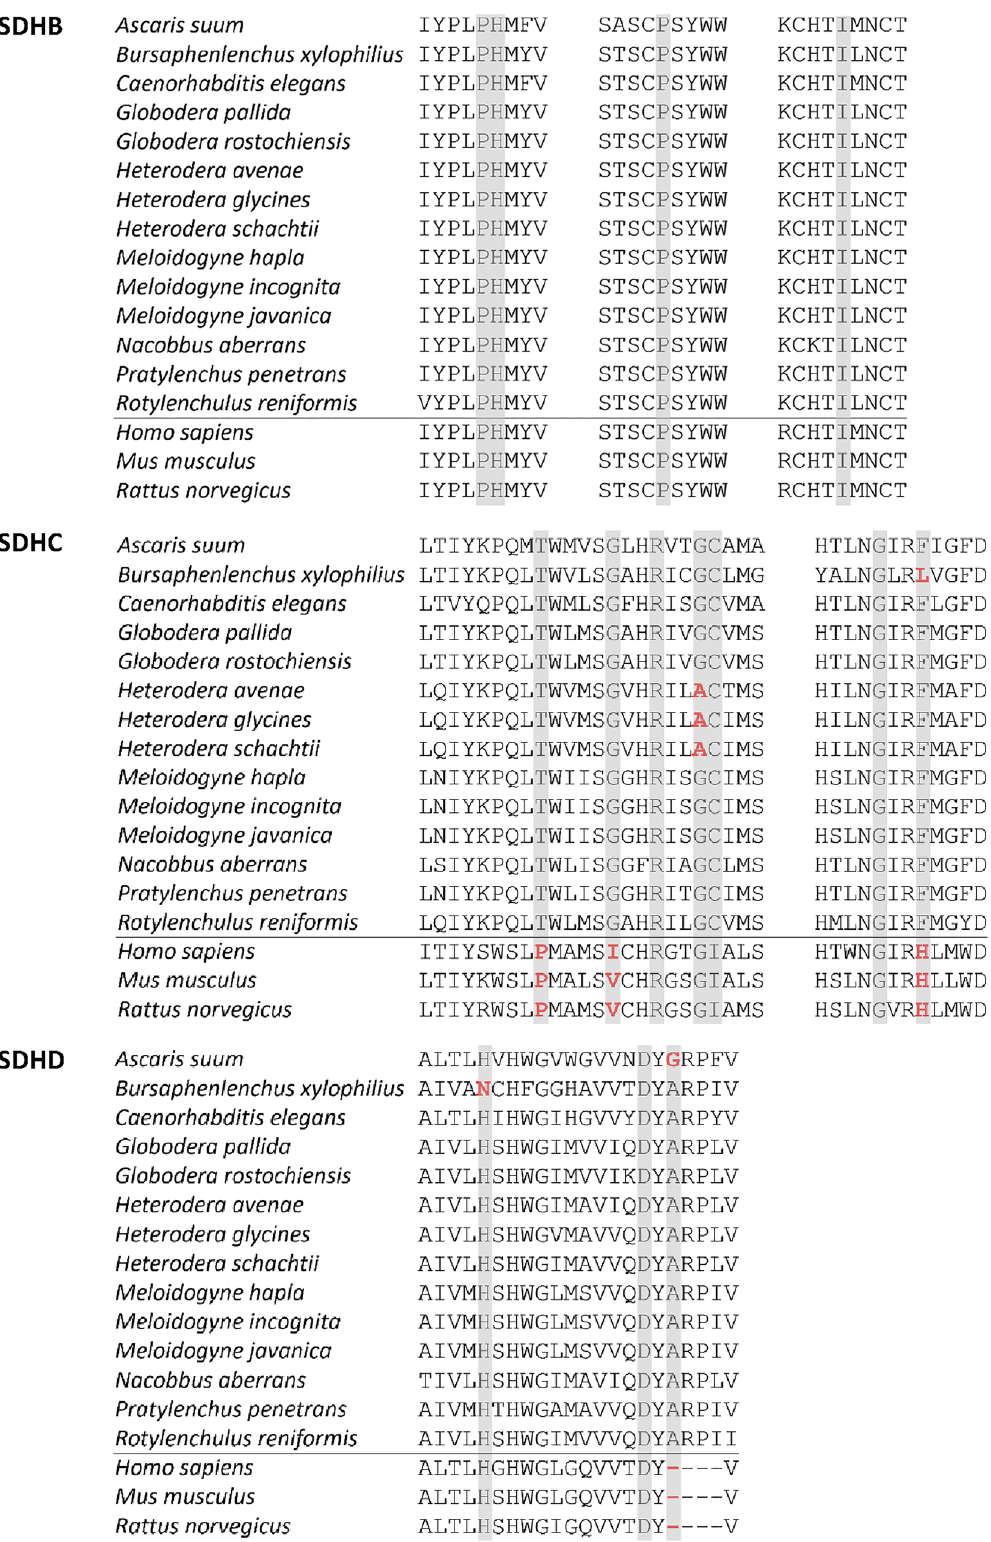
Figure 6. SDHB, SDHC and SDHD sequence comparison. Sequence parts and residues (highlighted in grey) identified to be involved in ligand binding in Caenorhabditis elegans according to Burns et al. 13 are displayed 13 . Differences to C. elegans are highlighted in